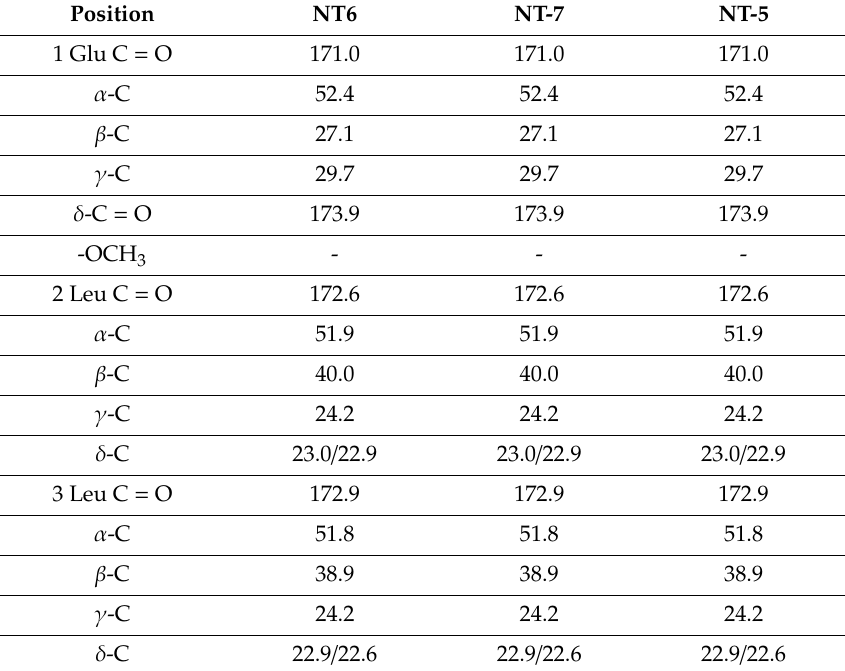
Position NT6 NT-7 NT-5